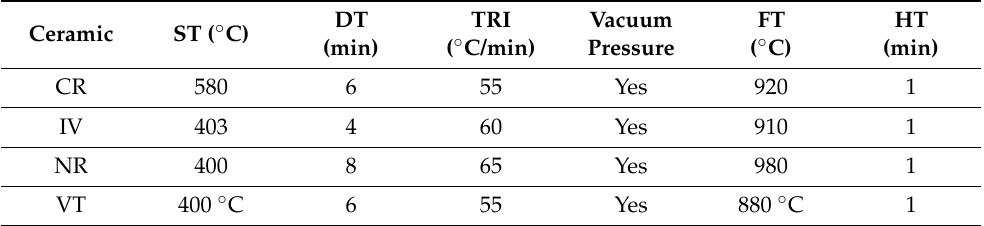
Table 2. Firing procedures of the dental ceramics tested. ST: starting temperature, DT: drying